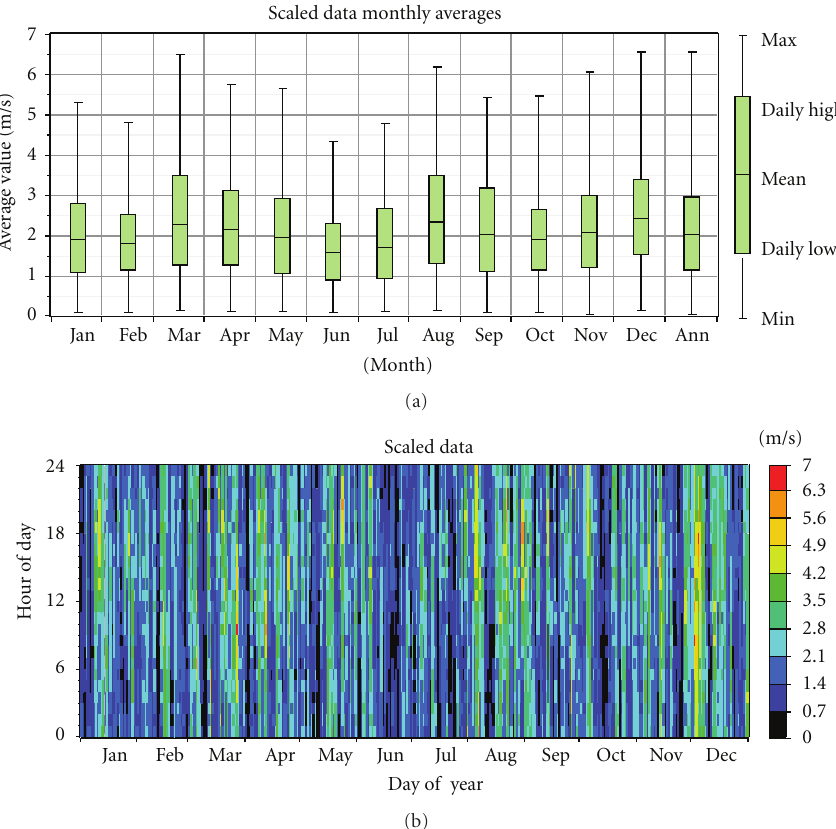
Figure 4: Synthetic series of wind speed at the site of the house at a height of 7 meters.